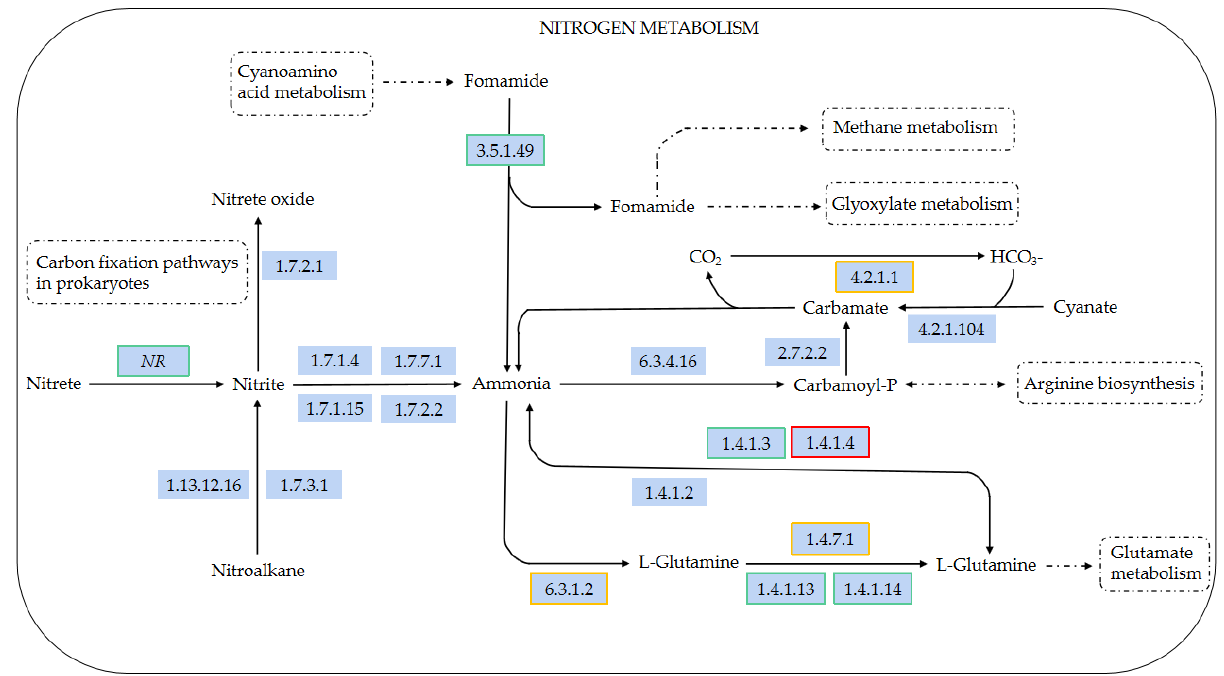
Figure 5. Nitrogen metabolism pathway of N. tangutorum under drought stress: (1) Red boxes denote the upregulated genes; green boxes denote the downregulated genes; yellow boxes denote the up/downregulated genes. (2) Black solid arrows denote molecular interactions or relationships; dotted arrows denote indirect effects; dotted boxes denote other signal pathway maps. (3) Letters and numbers on a blue background denote genes or enzymes involved in metabolic pathways. NR: ni-